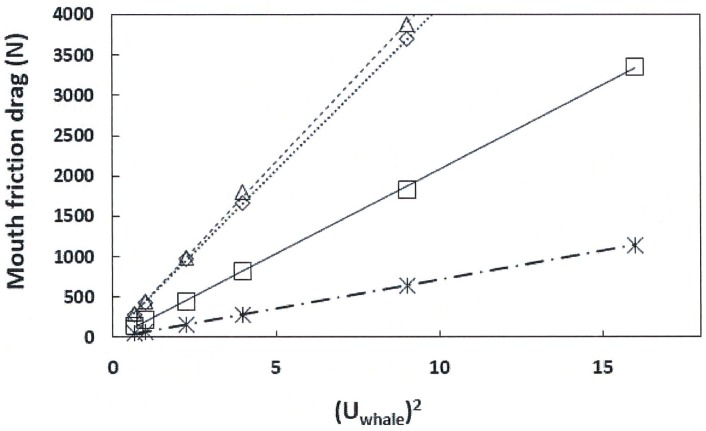
Calculated mouth friction drag versus the square of the swim speed and body size.Calculated via Eq 3 using the morphological inputs of Table 2 in the case C = 0.44 (“with prey” [9]). (Note—with 10m, dbaleen was set at 0.01m). The body lengths considered were 8m (starburst and dash-dot line), 10m (squares and continuous line), 15m-case B (diamonds and dotted line) and 15m-case A (triangles and dashed line) respectively. The slopes corresponding to the lines are as follows: 71.26 kg/m (8m; R2 = 0.99), 207.95 kg/m (10m; R2 = 0.99), 407.79 kg/m (15m-case B; R2 = 0.99) and 431.98 kg/m (15m-case A; R2 = 0.99). The presence of the straight lines in this plot suggest a swim speed-independent but body size-dependent drag coefficient for the drag generated by the internal flows of the oral apparatus (Eq 6b).